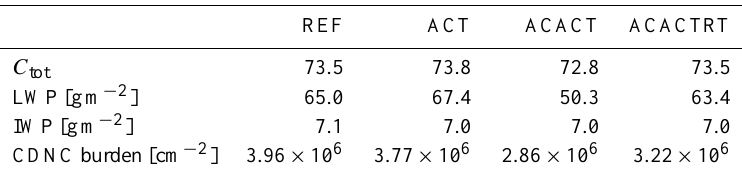
Table 2. Present-day global mean values in each model configuration for (from top to bottom) total cloud cover ( C tot ), liquid water path (LWP), ice water path (IWP) and CDNC